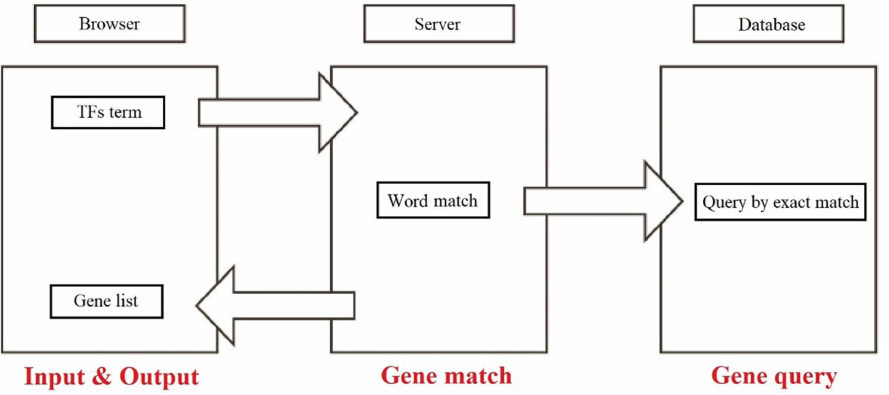
Figure 6. Workflow of the Aureobasidium Transcription Factor